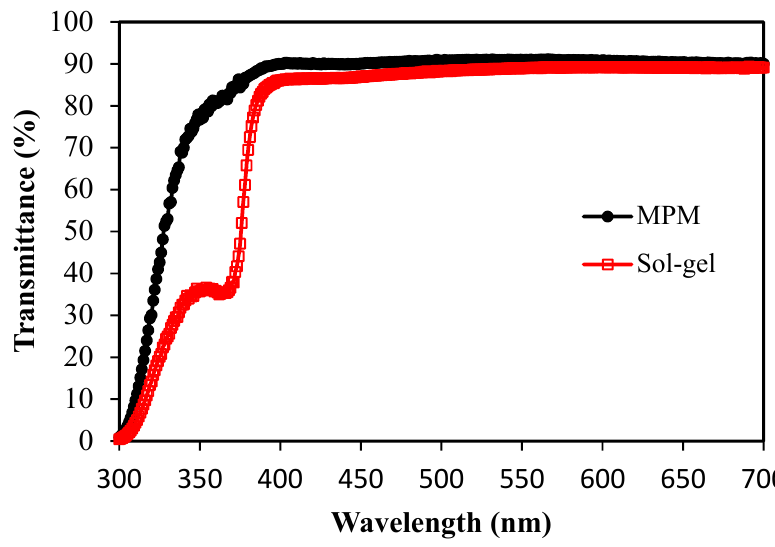
Figure 4. Transmittance spectra of ZnO fabricated via MPM and sol–gel methods.